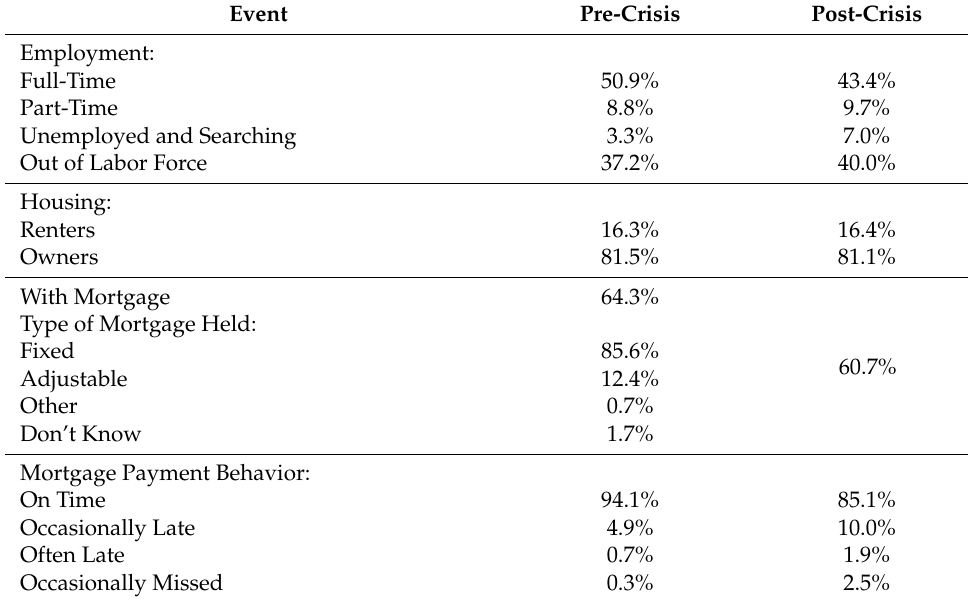
Table 2. The Financial Crisis: Employment, Housing and